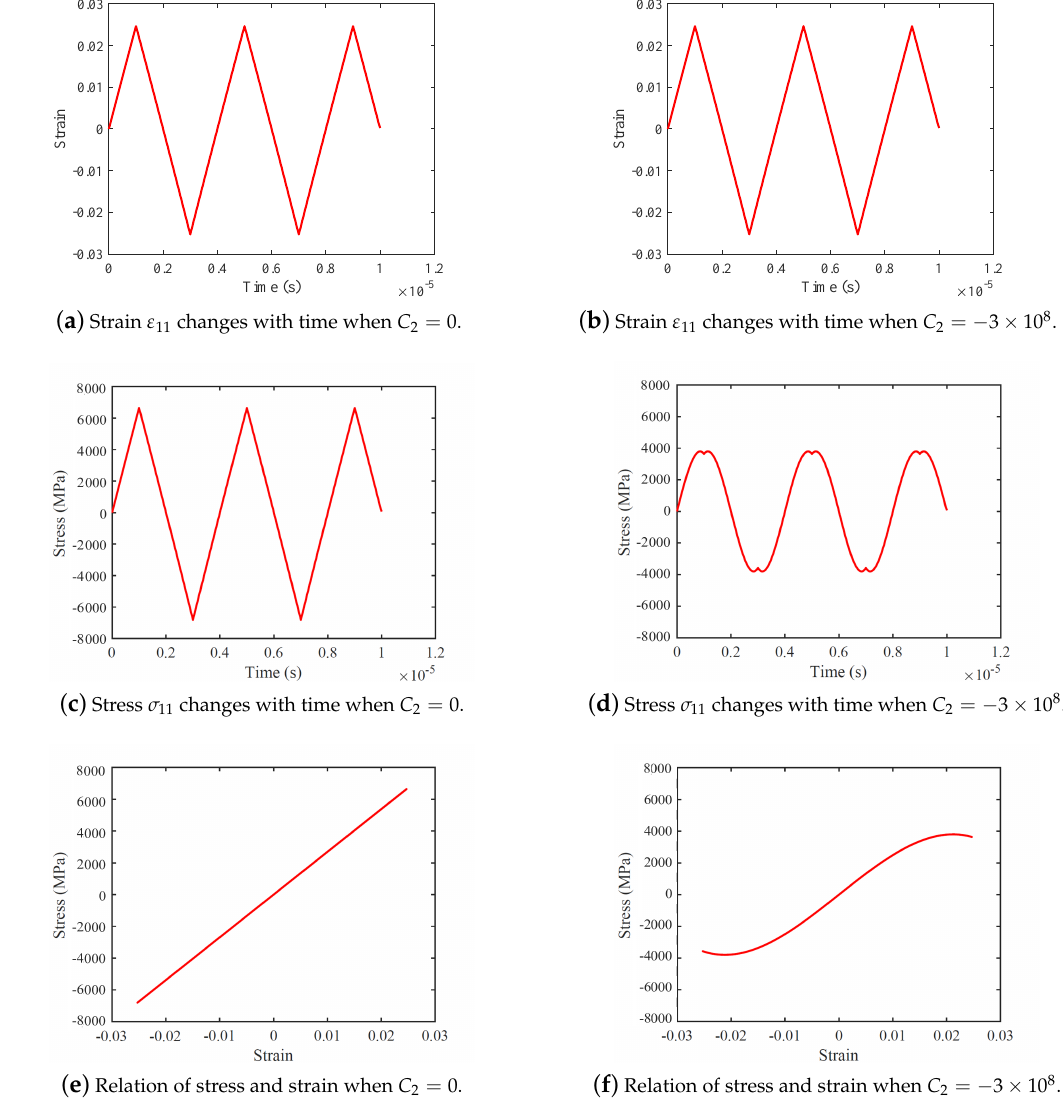
Figure 9. Comparative analysis of strain and stress when C 2 is equal to 0 and − 3 × 10 8 respectively.